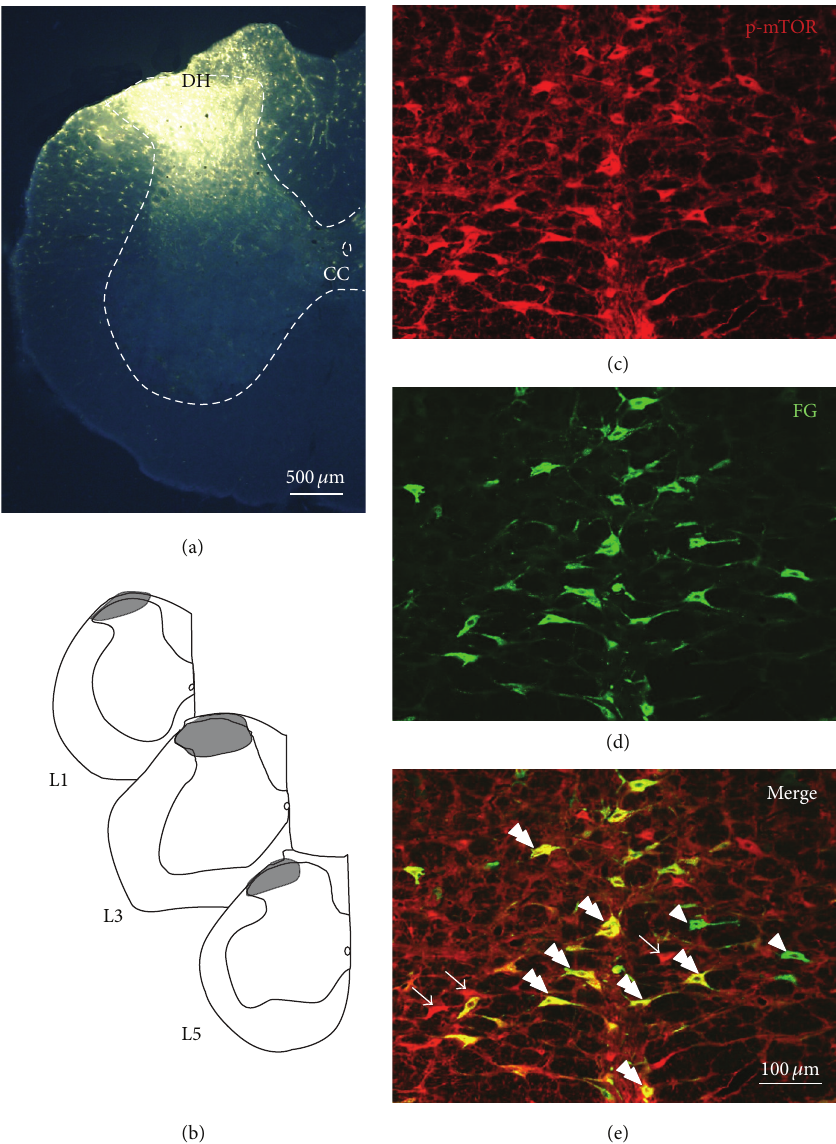
Figure 3: Most of the FG-labeled spinally projecting neurons in the RVM expressed p-mTOR. (a) Fluorescence photomicrograph showing the FG injection site in the lumbar spinal dorsal horn (SDH). (b) Camera lucida drawings show the rostrocaudal extent of the FG injection site at the different levels indicated, L1, L3, and L5. L1, L3, and L5 show the corresponding segments of the lumbar cord (DH: dorsal horn; CC: central canal). (c)–(e) Representative fluorescence photomicrographs showing p-mTOR (red) and FG (green) double-labeled neurons in the RVM. The double arrowheads indicate p-mTOR/FG double-labeled neurons (yellow), the arrowheads indicate FG single-labeled neurons, and the arrows indicate p-mTOR single-labeled neurons in the RVM. Scale bar = 500 𝜇 m in (a) and 100 𝜇 m in (e) (applied to